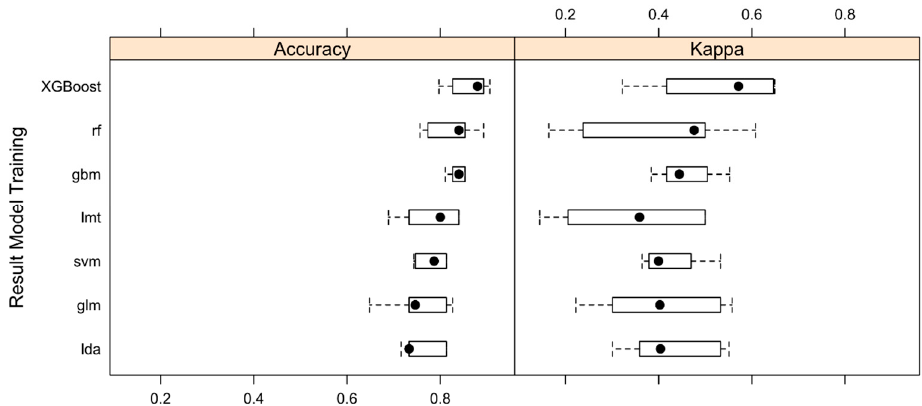
Figure 10. Results of the model training. A comparison of the cross-validated Accuracy and Kappa estimated from XGBoost (eXtreme Gradient Boosting), rf (Random Forest), gbm (Stochastic Gradient Boosting), lmt (Logistic Model Trees), svm (Support Vector Machine), glm (Generalized Linear Model) and lda (Linear Discriminant Analysis) for meteorological dataset [2].